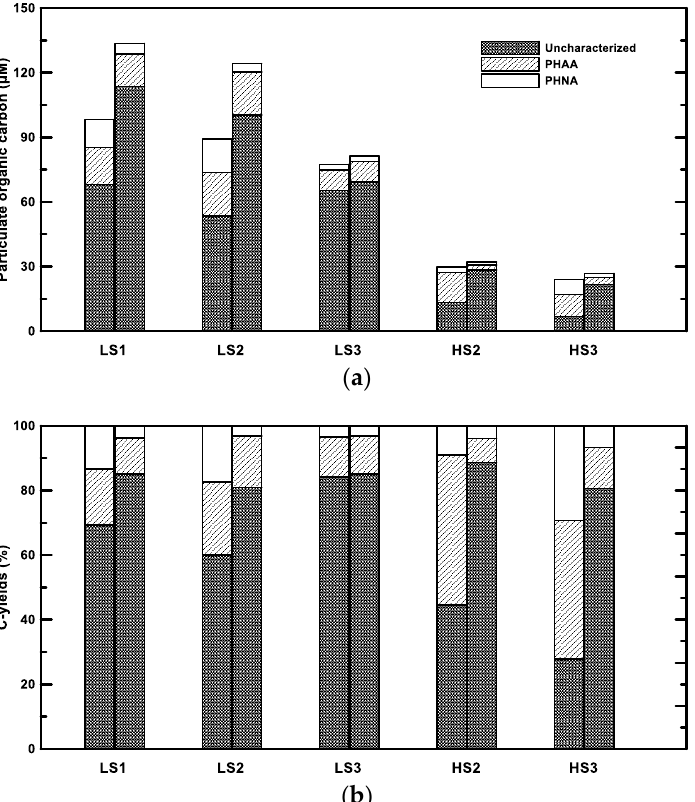
Figure 5. Chemical composition of POC in the field (the left column in each pair) and the treatment (the right column in each pair). ( a ) Concentrations. ( b ) C-yields. PHNA denotes particulate hydro- lysable neutral aldose and PHAA denotes particulate hydrolysable amino acid. LS and HS denote low- and high-salinity, respectively.